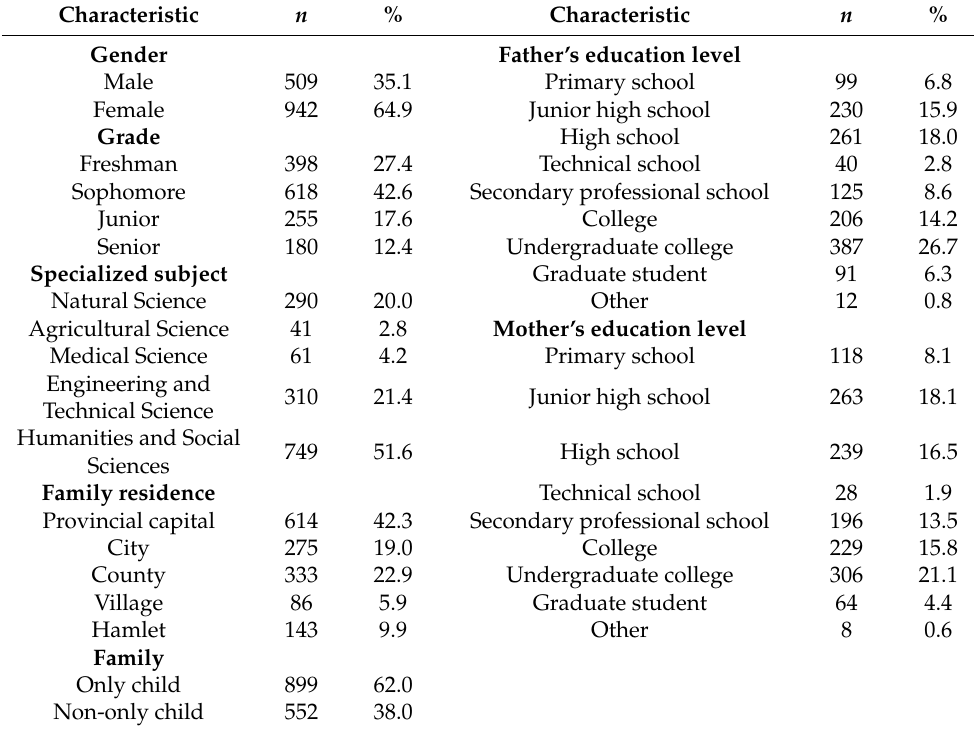
Table 1. Participants’ demographic variables ( n =